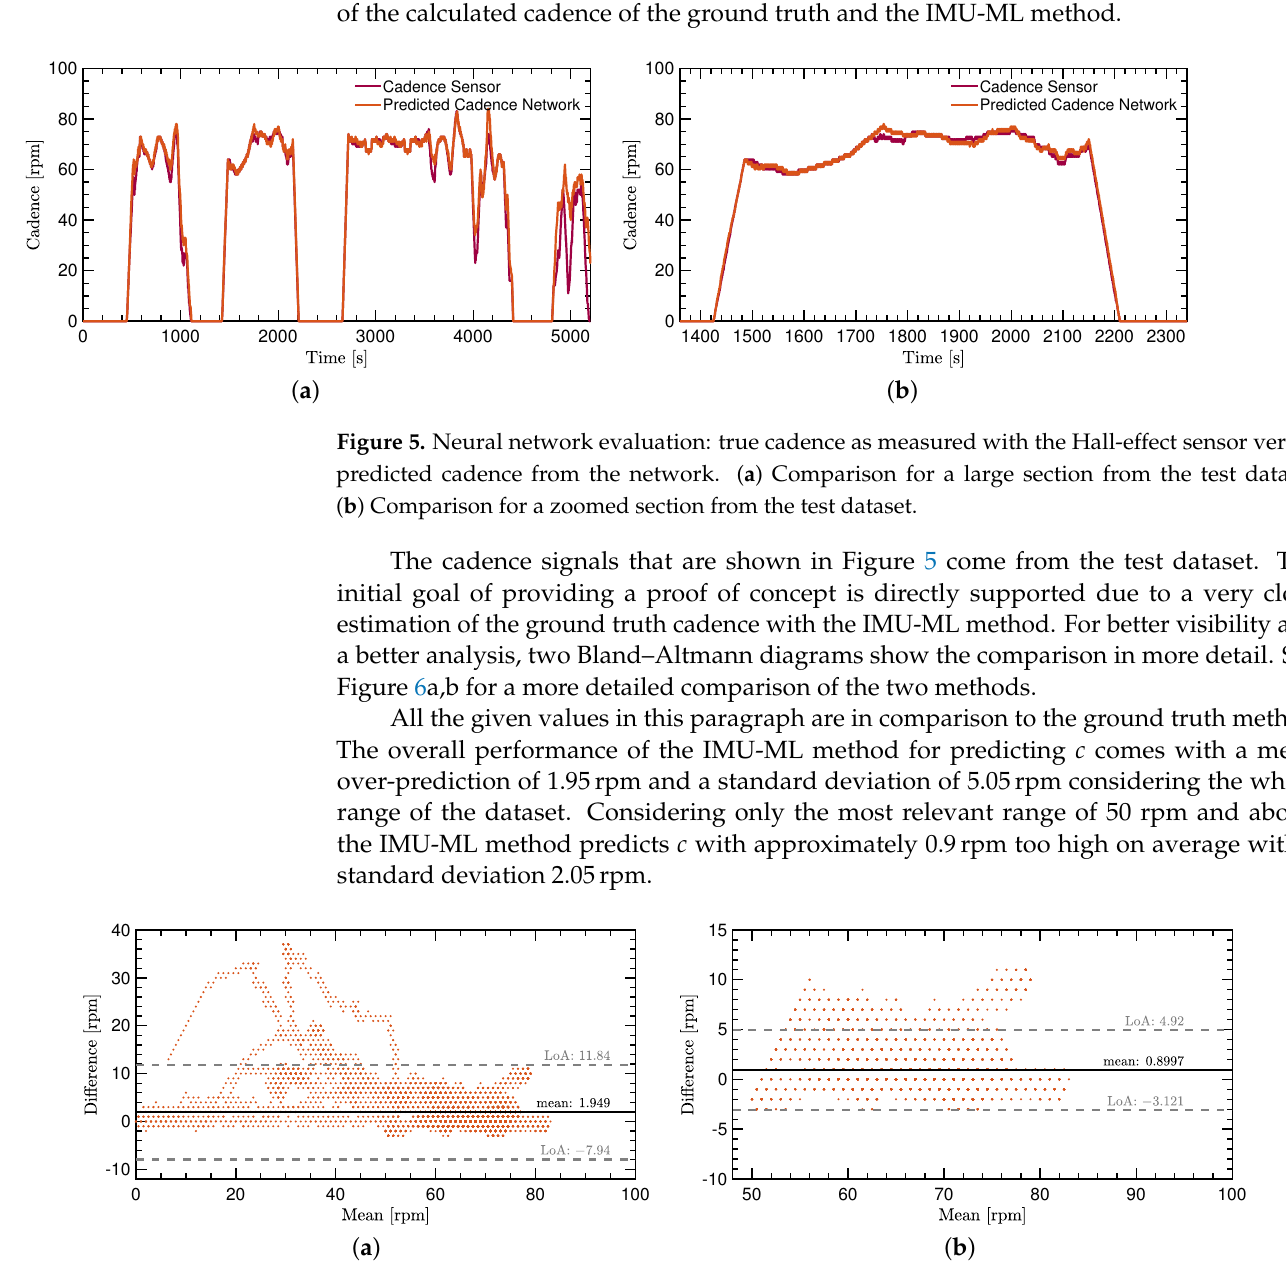
Figure 6. Bland–Altmann diagrams for the comparison of the IMU-ML method with the Hall- effect sensor used as ground truth. ( a ) Comparison for the entire cadence range in the dataset. ( b ) Comparison for 50rpm and